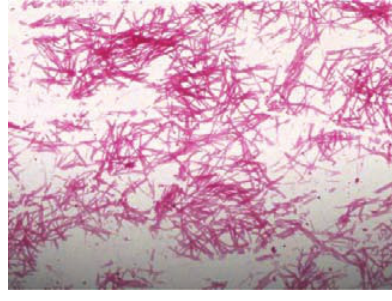
Figure 3. Gram stain of the sputum culture shows Leptotrichia sp. Magnification 400 ¥